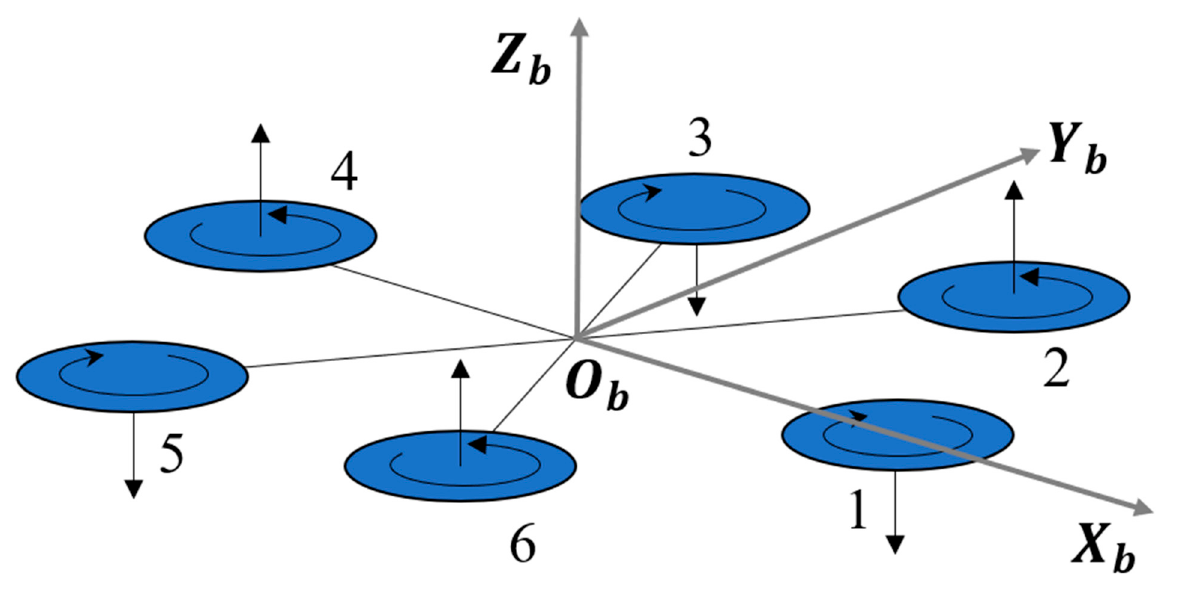
Figure 1. Kinematic scheme of a hexacopter.